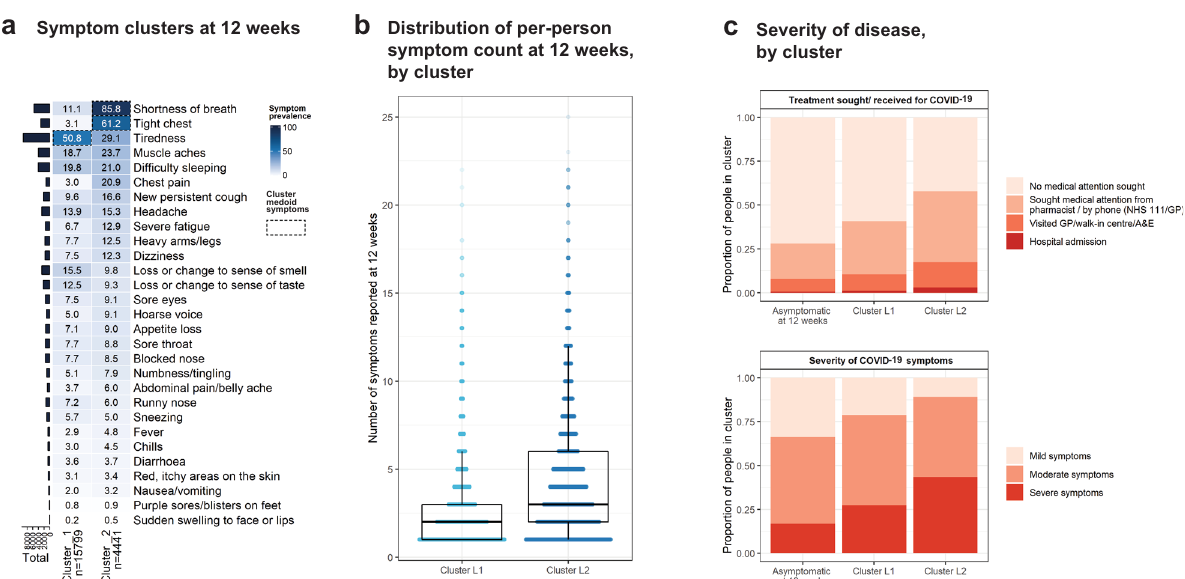
Fig. 5 Results of clustering on symptom pro fi le at 12 weeks. Clustering was conducted using CLARA (partitioning around medoids) algorithm. Two stable clusters were identi fi ed at 12 weeks. Cluster L1 ( “ tiredness cluster ” ) had high prevalence of tiredness. Cluster L2 ( “ respiratory cluster ” ) was a smaller subset of 4,441 participants who had high prevalence of shortness of breath and tight chest as well as chest pain. Panel a shows symptom prevalence by cluster. Panel b shows the distribution of symptom counts by cluster (median 2 symptoms for cluster L1 [ n = 15,799] and 3 symptoms for cluster L2 [ n = 4441]). Box plots in panel b show median, fi rst and third quartiles; whiskers indicate 1.5*the interquartile range; data beyond this range are plotted as points. Panel c shows the self-reported symptom severity and medical treatment sought by cluster (with those who were no longer symptomatic at 12 weeks for